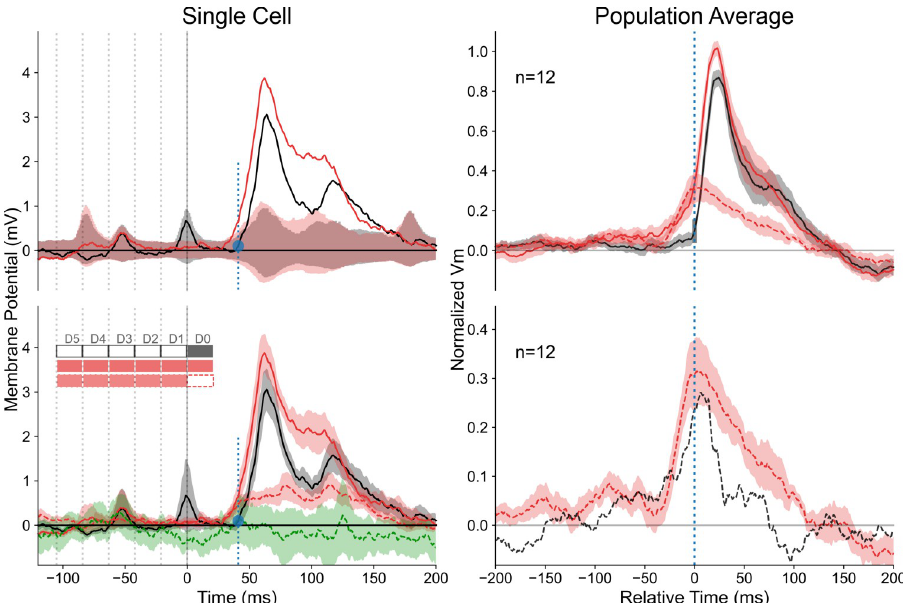
Fig 6. “Filling-in” responses evoked by Surround-Only AM (“radial” protocol). The analysis here is restricted to cells where Surround-Only CP-ISO stimulation evoked a significant response (n = 12, see Text for criteria). Trace color code: black for Center-only, red for Surround-then-Center, dashed red for Surround-Only, dotted green for Surround Linear Predictor (SLP). The left middle horizontal insets respectively show the chronograms of the stroke- by-stroke stimulation sequences for Center-Only (1 stroke, filled black box, upper line), Surround-Then-Center (6 strokes, filled red, middle line) and Surround-Only (5 strokes, filled pale red, bottom line) protocols. Empty boxes indicate omitted stimuli. The time onset of each GP stroke is labeled by a thin dotted vertical line. In this figure and the following ones, the blue dot and vertical dotted blue bar on the y-axis indicate the “threshold” amplitude change of the Center-Only control curve from rest, above which statistical significance of the response is reached (p < 0.01) for each individual cell. Their abscissa serves as a reference for the temporal realignment of the different contextual responses. Left : Single cell example. Top left : The confidence intervals (permutation test; 104 repetitions, p < 0.01) for Center- Only and Surround-then-Center compared to Blank are represented respectively by gray and pale red envelopes. The complete CP-ISO AM sequence (D5 to D0) evokes a significant facilitation of the Center-Only Vm response. Bottom Left : The red and black curves represent the response averages across trials (shaded area: ± SEM). When omitting the D0 stroke, the recruitment by the CP-ISO AM flow, although limited to the silent surround (D5 to D1), still induces a significant depolarizing activation (Surround-Only: dashed red). The temporal profile of the lateral wave of activity matches the "predicted" invasion of the RF Center (black), had it been stimulated. The build-up of the Surround response during AM departs significantly from the sum of the static responses evoked by each distal GP stroke in isolation (Surround linear predictor (SLP): dashed green, confidence interval of a significant difference between SLP (predicted) and Surround-Only (observed) waveform, p < 0.05). Right, top panel : Average response profiles for Surround-then-Center, Center-Only and Surround-Only conditions (n = 12). Right, bottom panel : the CP-ISO Surround-Only response (mean: dotted red ± SEM: shaded area) is compared (with a different ordinate scale than in the top right panel) with the “expectation” (dashed black trace) obtained by subtracting the Center-Only (black trace, top right) from the complete CP-ISO AM response (red trace, Top